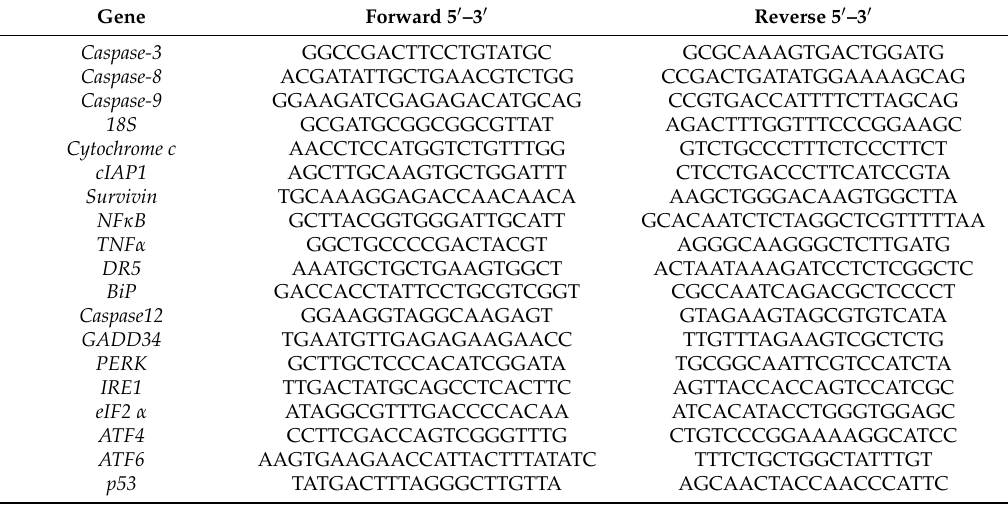
Table 2. Primer sequences used in the Real-Time